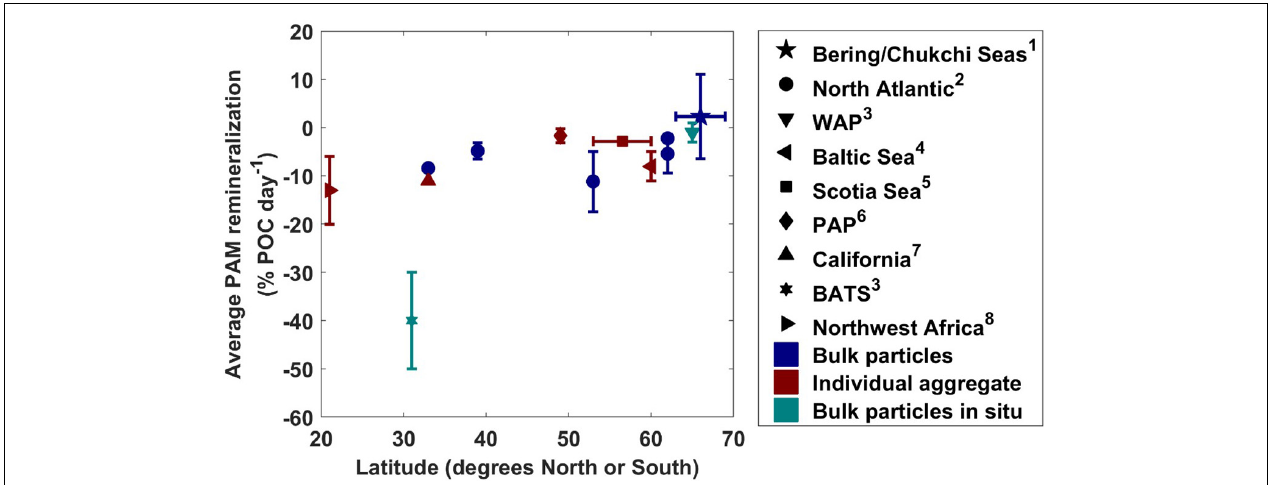
FIGURE 6 | Average particle-associated microbial respiration rates (with one standard deviation plotted as vertical error bars) from this study along with previous measurements at other latitudes. Symbols colored with navy indicate bulk particle respiration measurements, teal indicate measurements taken with RESPIRE in situ incubator, and maroon indicate rates measured from individual aggregates. WAP, Western Antarctic Peninsula; PAP, Porcupine Abyssal Plain; BATS, Bermuda Atlantic Time Series. Measurements were taken from this study 1 , Collins et al. (2015) 2 , McDonnell et al. (2015) 3 , Ploug and Grossart (2000) 4 , Belcher et al. (2016a) 5 , Belcher et al. (2016b) 6 , Ploug and Jorgensen (1999) 7 , and Iversen and Ploug (2010) 8